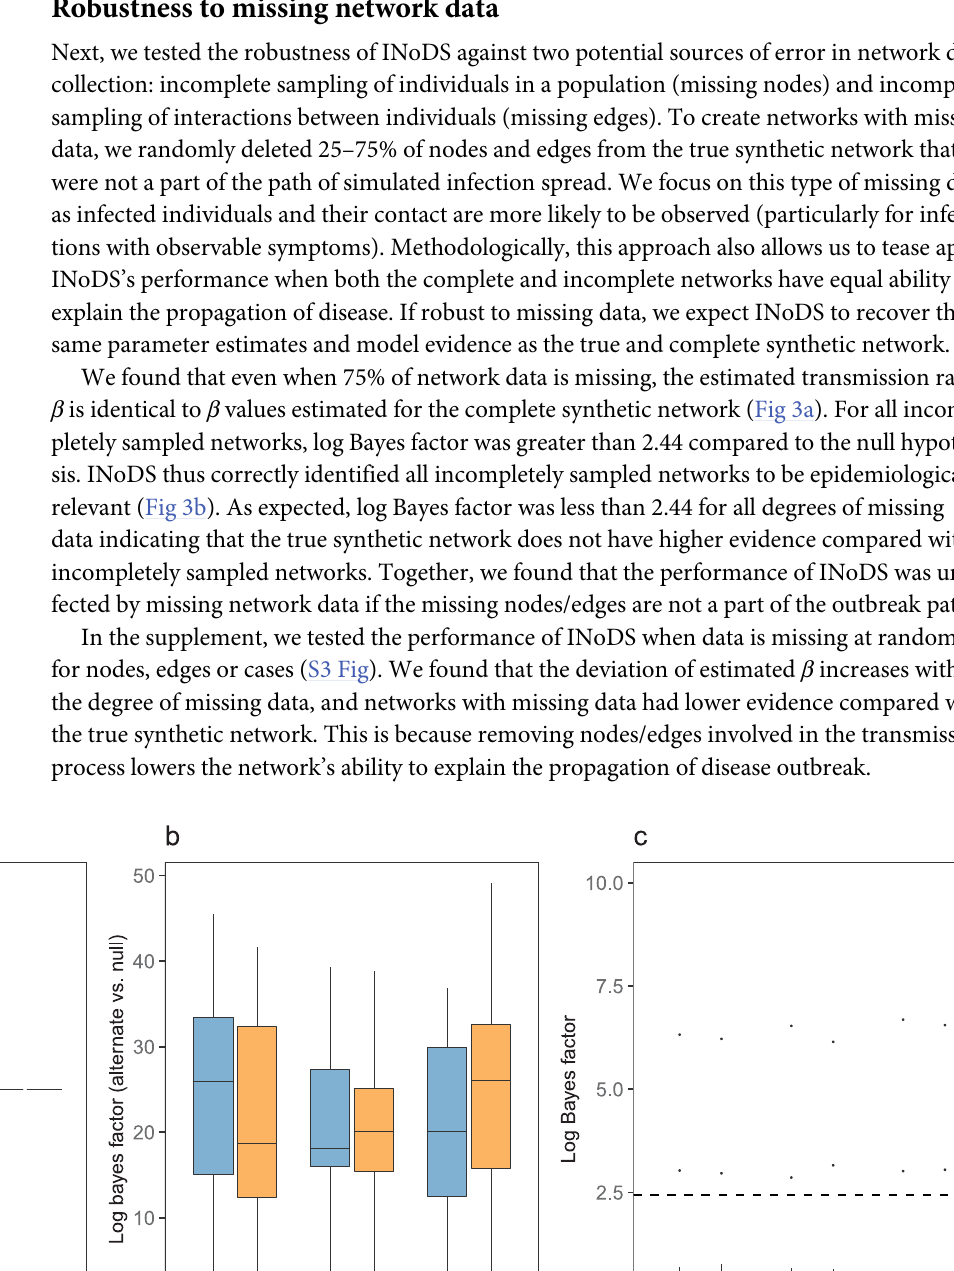
PLOS Computational Biology | https://doi.org/10.1371/journal.pcbi.1009604 December 20,